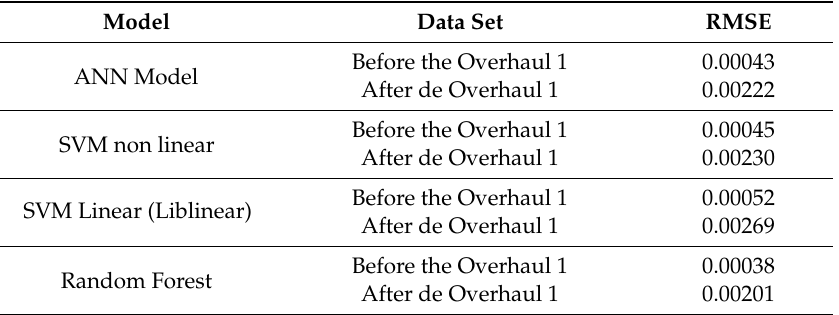
Table 6. Benchmarking the result of the di ff erent predictive analytics